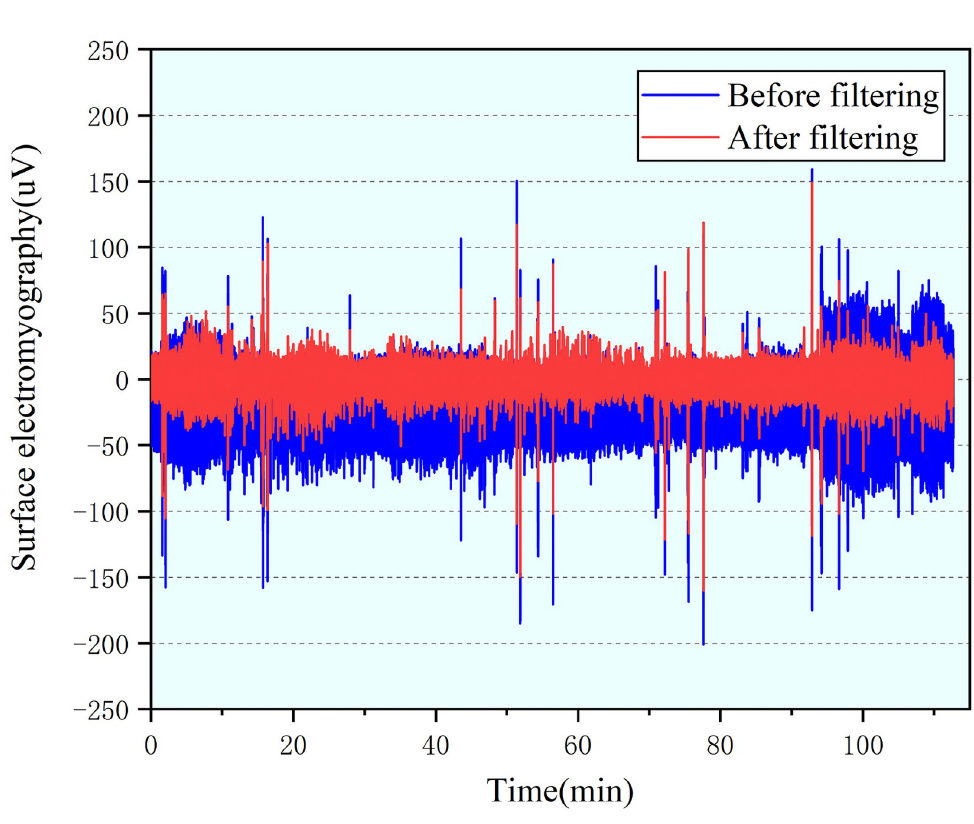
Fig 9. Comparison of sEMG signal before and after